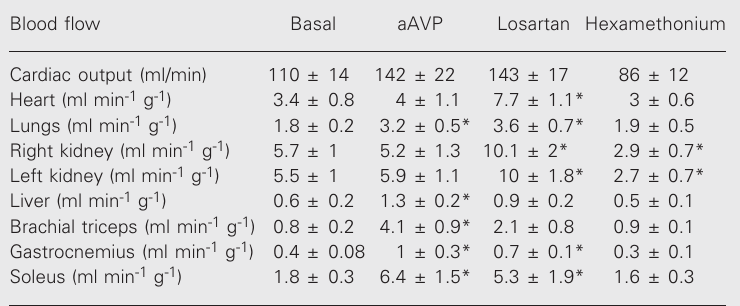
Table 1. Cardiac output and blood flow evaluations during vasopressor system blockade. Blood